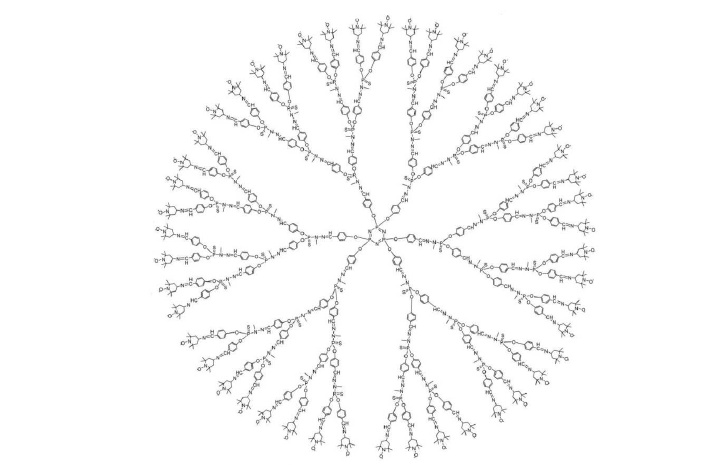
Figure 1. D 1 ( n ) with n =